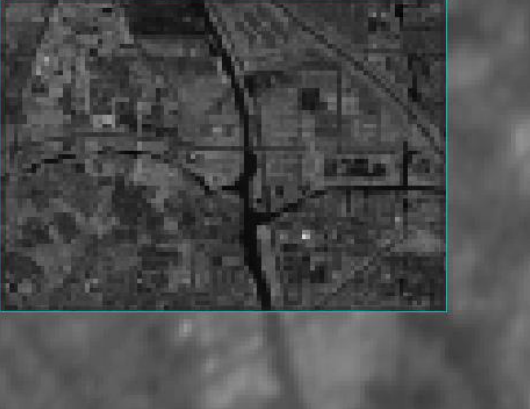
Figure 3. With RPC correction of July 23